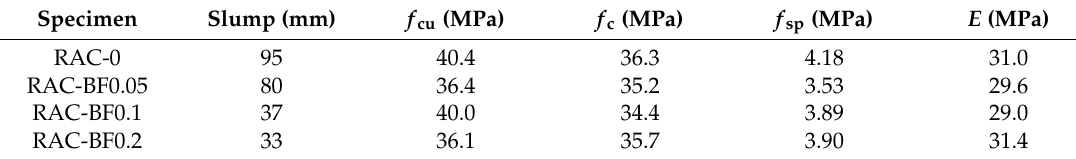
Table 6. Test results of RAC specimens having different BF volume